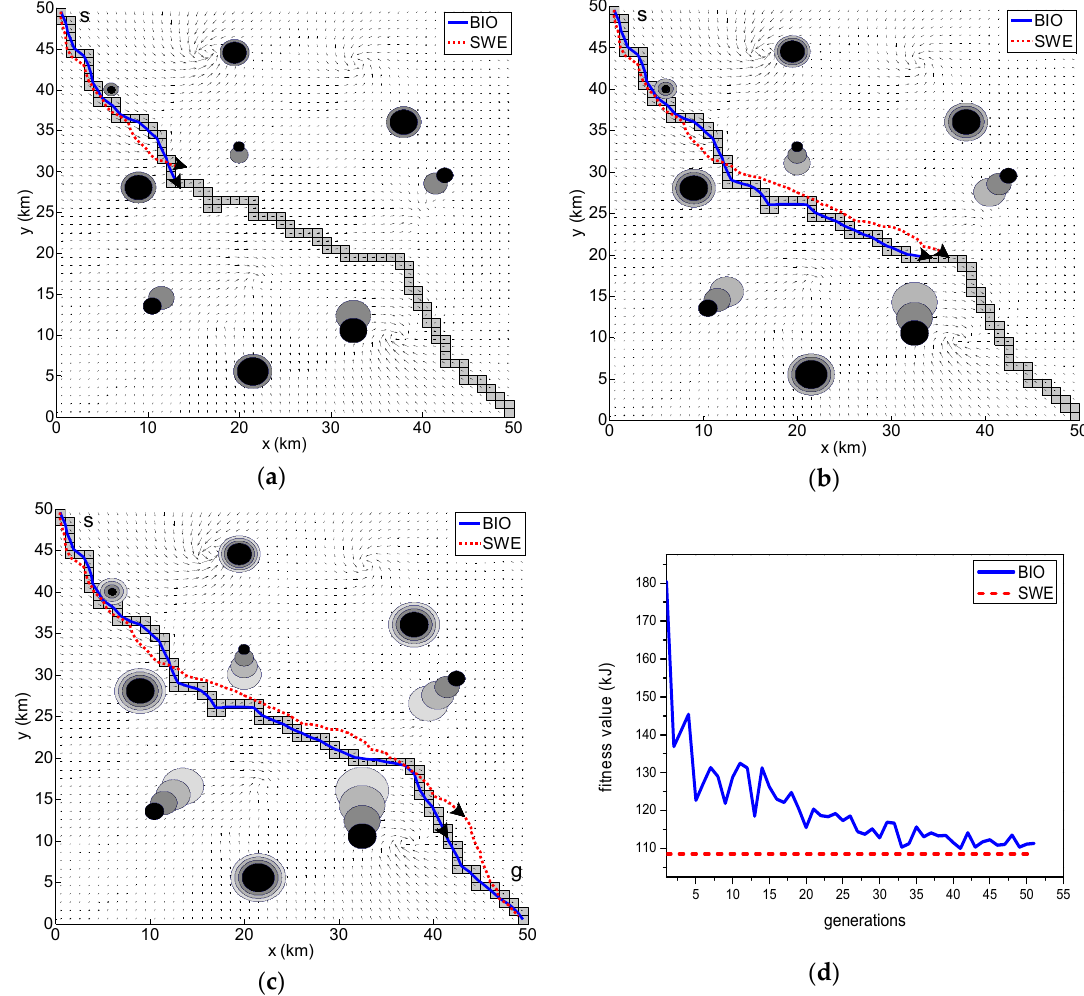
Figure 7. Comparison of results produced by the BIO and SWE schemes in the environment with varying uncertainty obstacles: ( a – c ) the optimal path generated by BIO and SWE schemes in 3 time steps. ( d ) convergence curve of the upper level of BIO scheme.